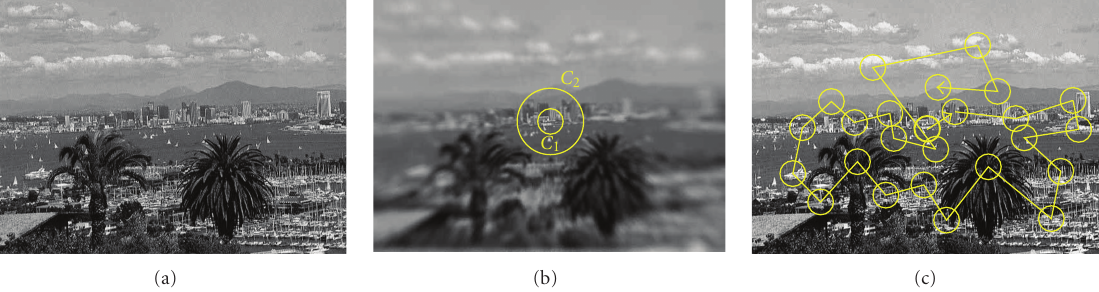
Figure 1: (a) San Diego skyline and harbor. (b) Progressively blurred image of (a) simulating the progressive loss of retinal acuity with eccentricity. The circle C 1 encloses the part of the scene projected onto the high-acuity fovea of a 2 deg diameter. The circle C 2 encloses the part projected onto the visually useful foveal region of a 5deg diameter. (c) A scanning path the eyes may take to build up the scene understanding. Adapted from [34].